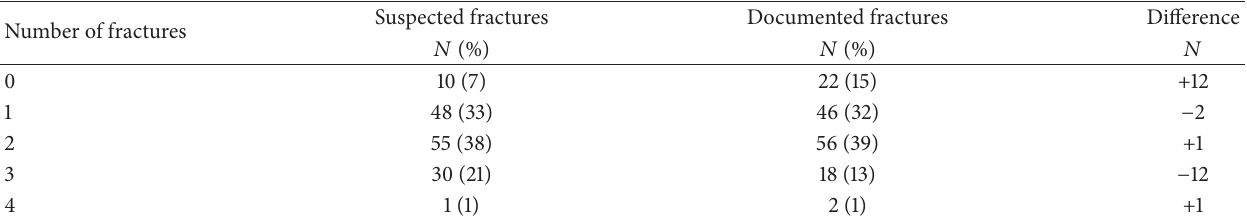
Table 3: Number (%) of patients with suspected and documented fractures ( 𝑁 = 144 ).